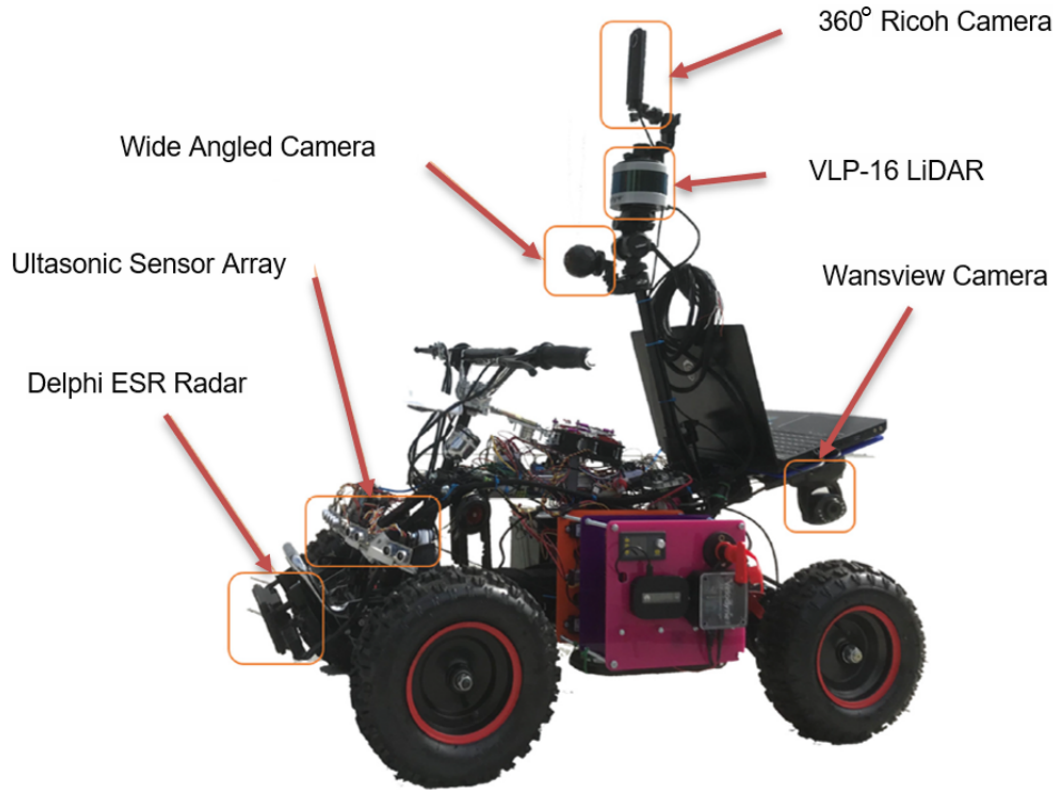
Figure 2. Loughborough University London Autonomous Testbed used for data collection.